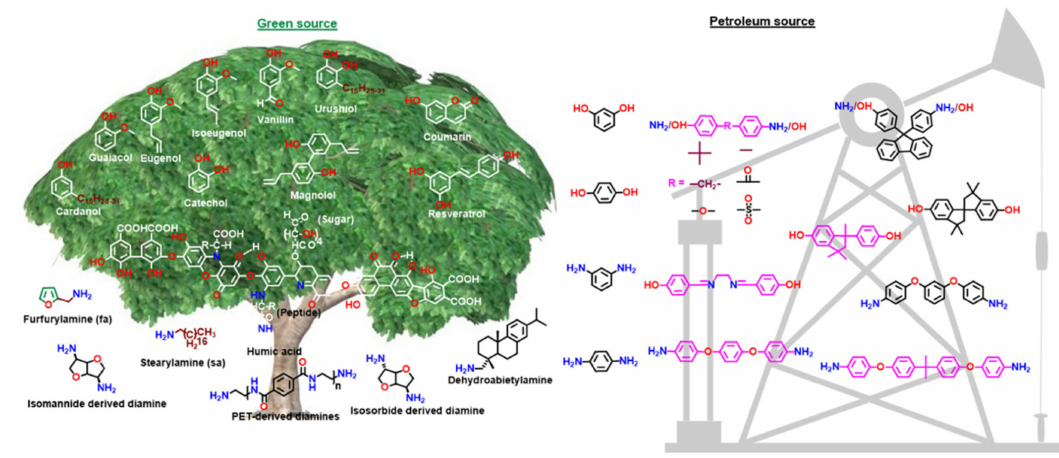
Figure 3. Representative bio- and petro-sourced phenolic and amine resources utilized to form Bz